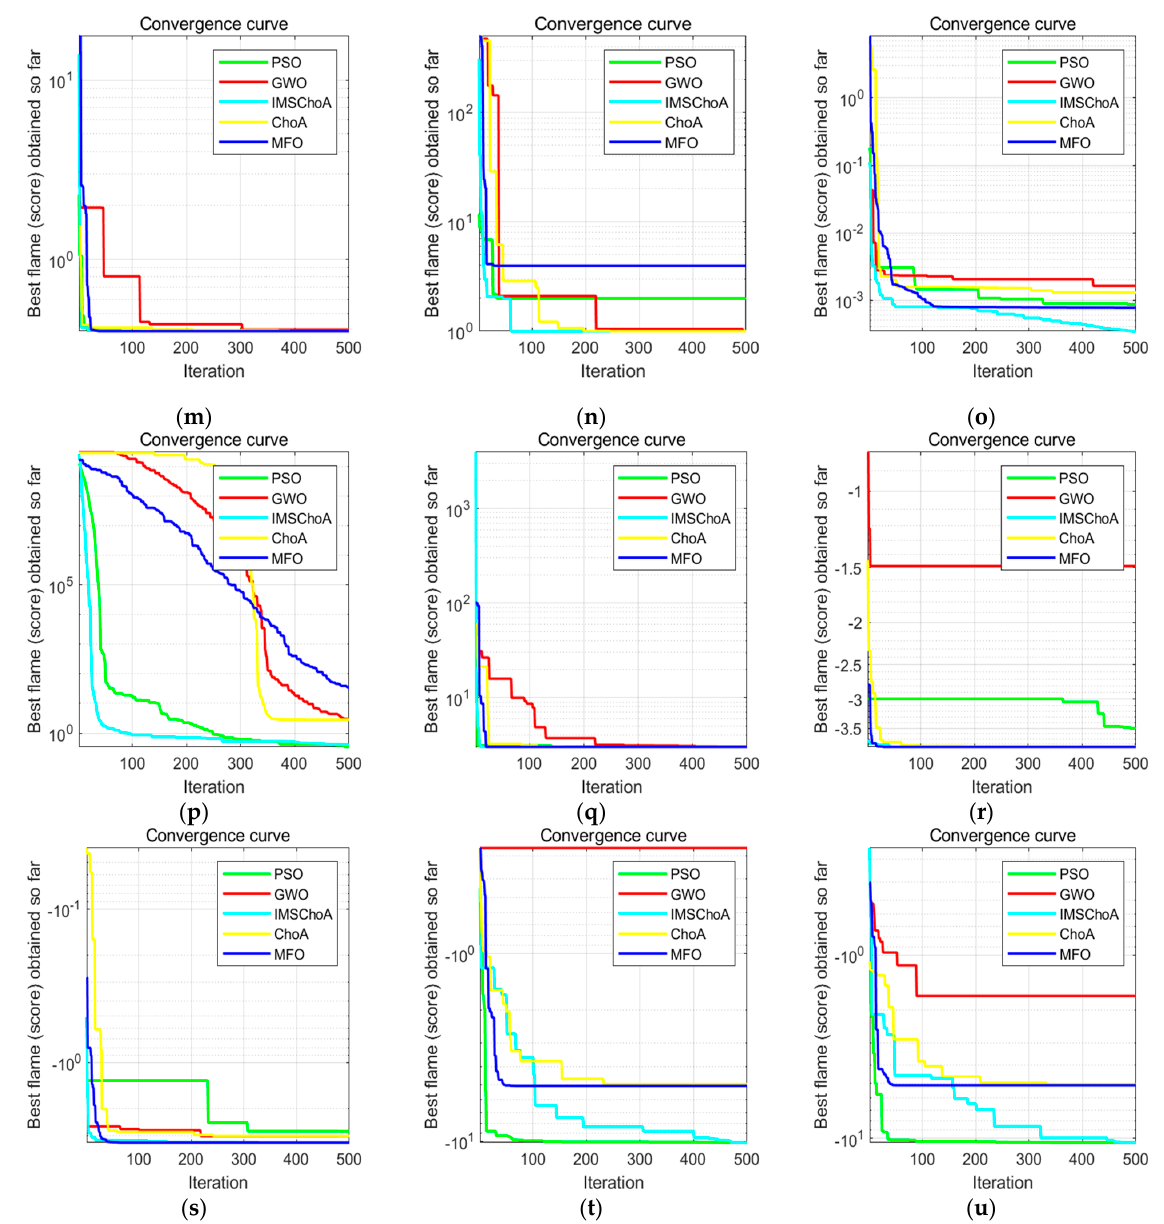
Figure 10. Convergence curves of different functions. ( a ) F1 function; ( b ) F2 function; ( c ) F3 function; ( d ) F4 function; ( e ) F5 function; ( f ) F6 function; ( g ) F7 function; ( h ) F8 function; ( i ) F9 function; ( j ) F10 function; ( k ) F11 function; ( l ) F12 function; ( m ) F13 function; ( n ) F14 function; ( o ) F15 function; ( p ) F16 function; ( q ) F17 function; ( r ) F18 function; ( s ) F19 function; ( t ) F20 function; ( u ) F21 function.